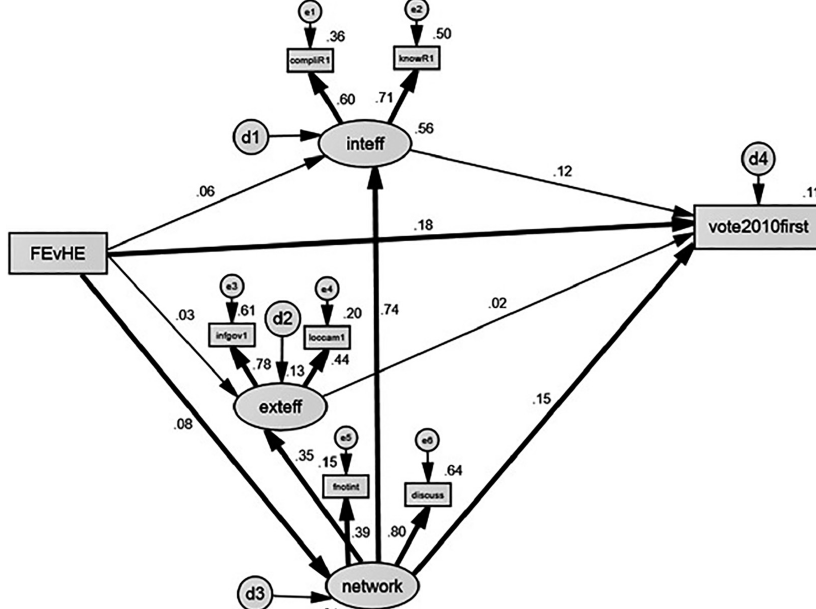
Figure 3: FE versus HE experience and 2010 turnout (standardised results); Chi-square 263.840 (13 d.f.), p=.000, RMSEA =.046, CFI =.965. Source: 2011 CITS (Online responses), n=1,883